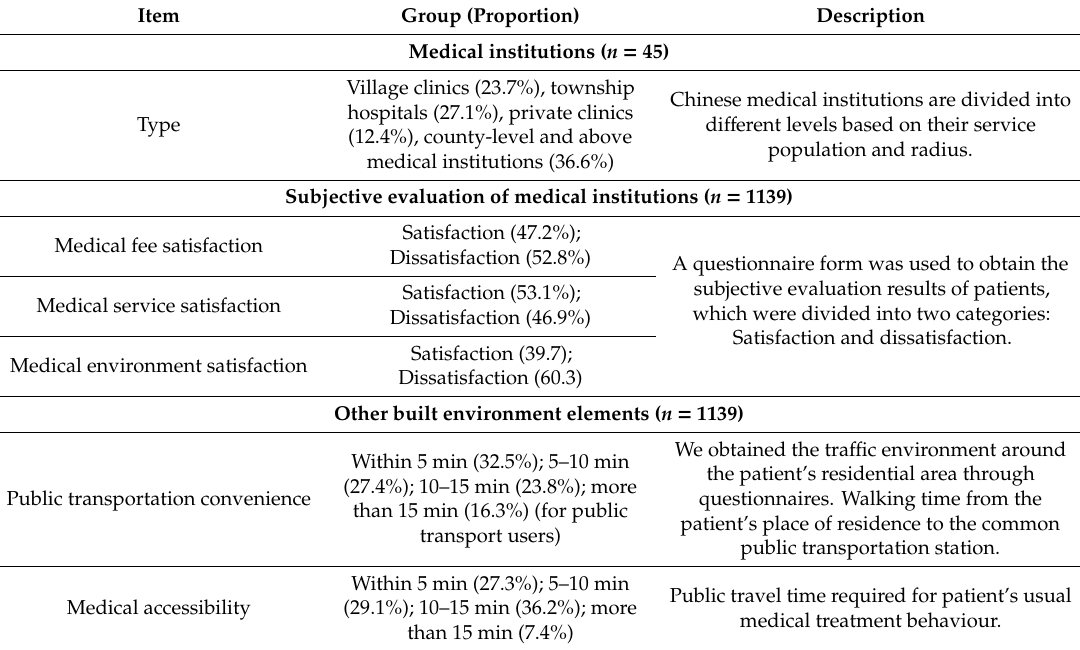
Table 2. The conditions of medical institutions and other built environment